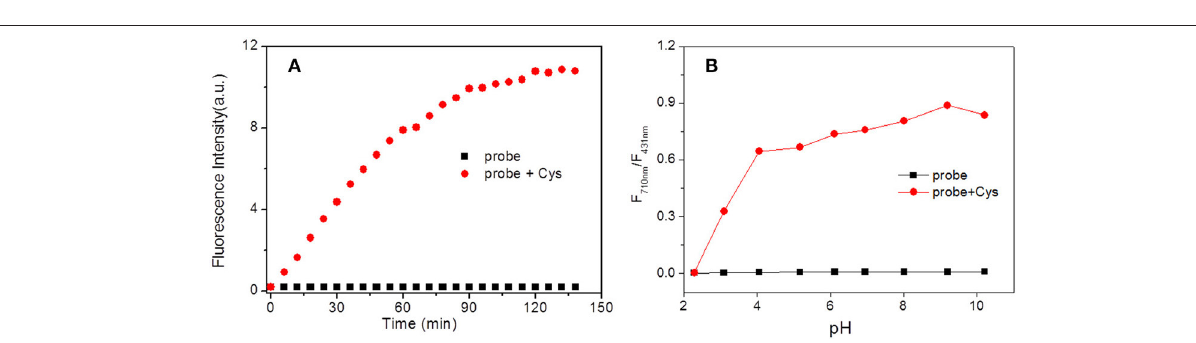
FIGURE 3 | Time (A) and pH (B) effect on fluorescence intensity of HBT-Cys in the absence and presence of Cys. The fluorescence intensity measured at 710nm in (A) . The measurements were performed in aqueous PBS buffer solution (pH = 7.4, 50% DMF) and the excitation wavelength was 396nm for fluorescence